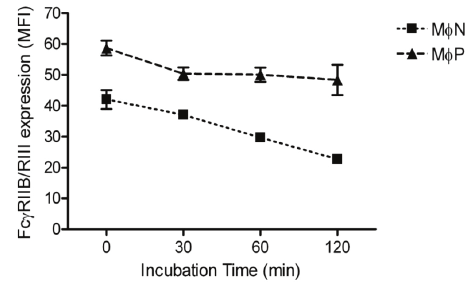
Figure 4. Internalization of Fc γ RIIB/RIII in M φ N and M φ P. Internalization kinetics of mAb 2.4G2-Fc γ RIIB/RIII complexes was monitored by flow cytometry during 120 min, as